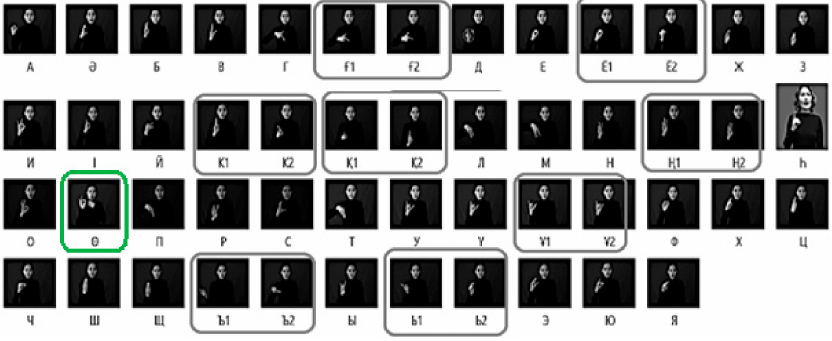
Figure 1. Kazakh Sign Language dactyl alphabet.